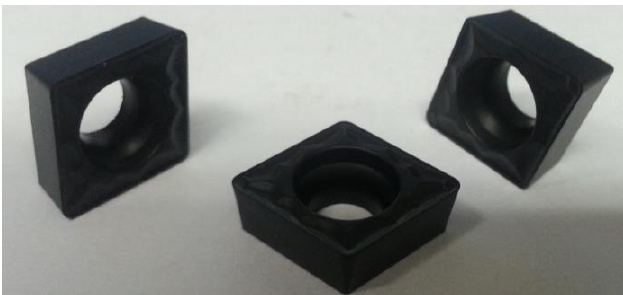
Figure 5. Cutting inserts used for the preparation of the tested workpieces.